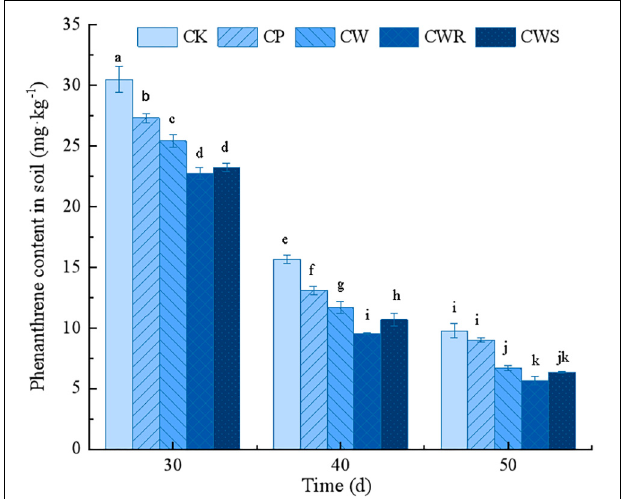
FIGURE 4 | The phenanthrene residues in soil after inoculation for 30, 40, and 50 days. CK, contaminated soil; CP, contaminated soil inoculated with strain Phe15; CW, contaminated soil planted with white clover; CWR, contaminated soil planted with white clover and inoculated with strain Phe15 via root irrigation; CWS, contaminated soil planted with white clover and inoculated with strain Phe15 via soaked seed. The different lowercase letters on the bars indicate significant differences among treatments ( P <